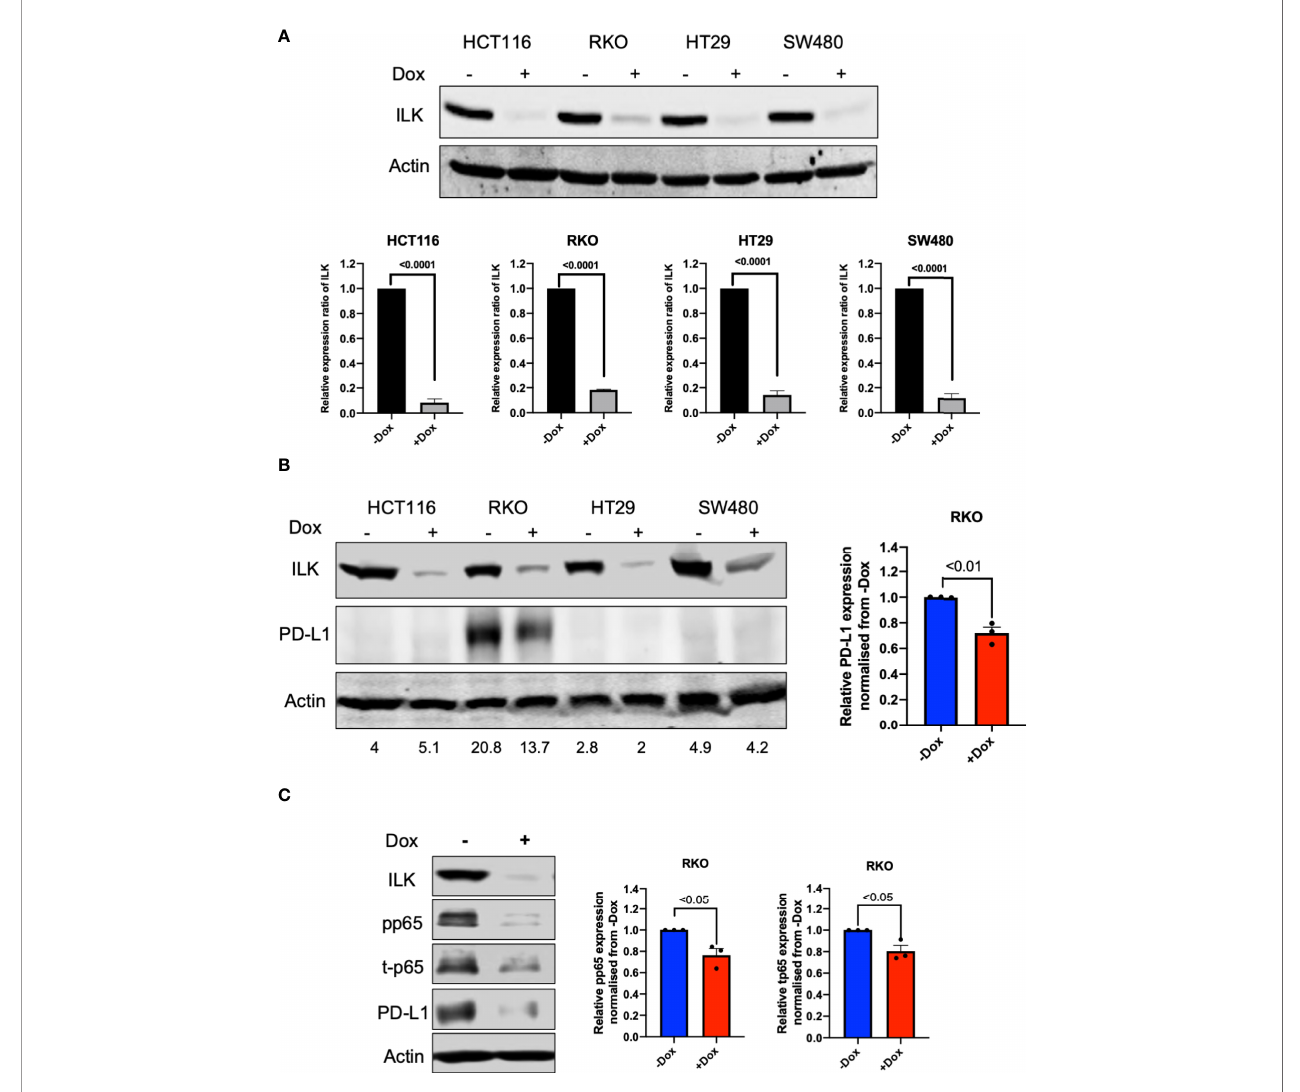
FIGURE 9 | ILK KD reduced basal PD-L1 expression in RKO CRC cells via NF- k B p65 regulation. [ (A) , upper] Western blot showing expression of ILK protein. [ (A) , lower] Quantitation of ILK protein, the means were normalized to -Dox (n = 3). Cells were seeded into a 6-well culture plate and duplicated into 2 sub-populations and incubated overnight. One sub-population per cell line was treated with 2 µg/ml doxycycline to induce CRISPR/Cas9 to delete the ILK gene over 3 days. The doxycycline was washed from the cells and the cells sub-cultured for growing. The cells were then harvested for testing ILK protein expression via western blot and the Dox-treated cells are veri fi ed as ILK KD cells. (B) The western blot of PD-L1 protein expression in CRC cell lines at the basal level. (C) ILK KD reduced NF- k B p65/PD-L1 protein expression in the RKO CRC cell line. (left) The western blot showed the effect of ILK KD in RKO cells on PD-L1 and NF- k B p65 (total and phosphorylated) protein expression at 4 hr serum stimulation following overnight starvation. (right) The quantitation of PD-L1, p65 phosphorylation (pp65) and p65 total protein expression (t-p65). Quantitation of protein expression normalized to -Dox. Actin was used as an internal control. Error bars are represented as mean ± SEM (n = 3). P -value was analyzed with an unpaired t-test. The signi fi cant P -value is <